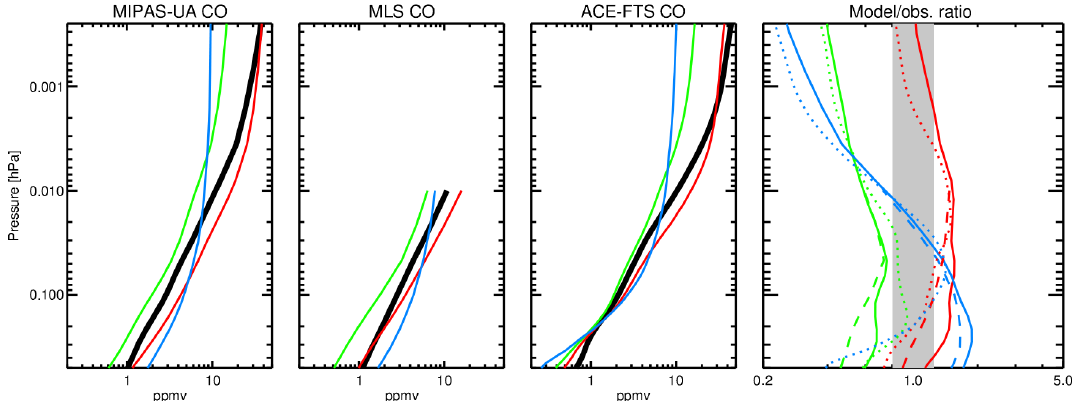
Figure 4. Comparison of observed polar mid-winter CO mean profiles (thick black lines) to 3dCTM (blue), HAMMONIA (green), and WACCM (red). Right panel: ratio of model results and MIPAS-UA (solid), MLS (dashed), and ACE-FTS (dotted) observations. The grey shaded area indicates the ± 25% range. Data have been averaged over 70–90 ◦ N and 5 December 2008–12 January 2009 (60–90 ◦ N and 5 November 2008–12 January 2009 in the case of ACE-FTS).